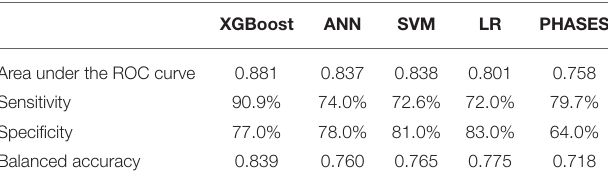
TABLE 2 | Performance comparison of machine learning models, logistic regression model, and the PHASES score